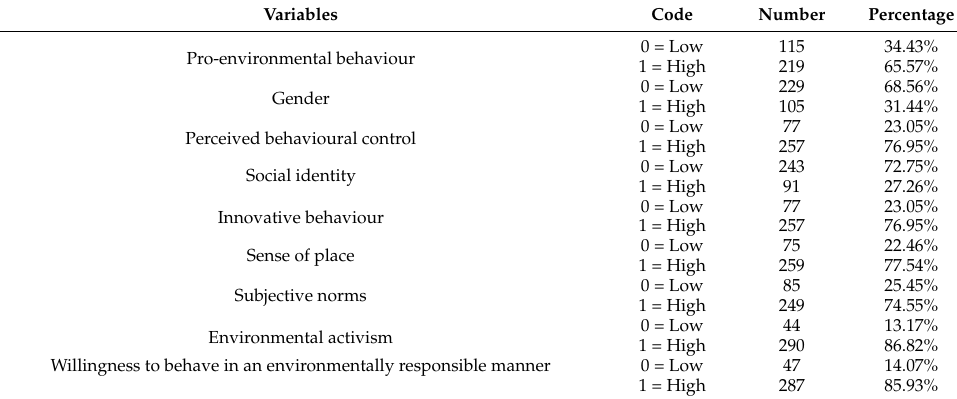
Table 2. Coding of